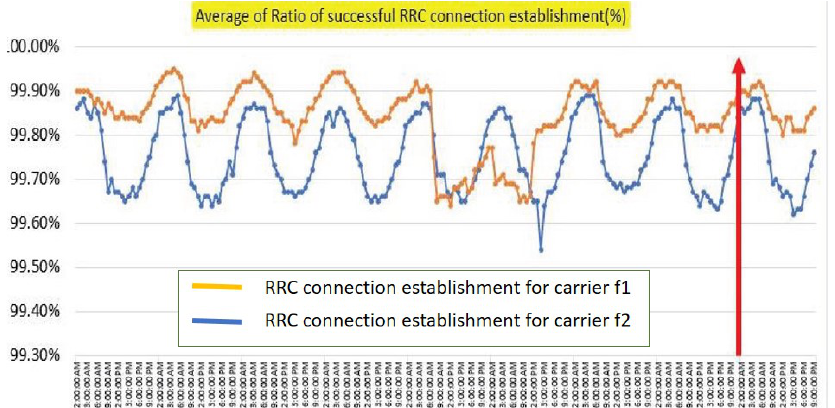
Figure 7. Radio resource connection (RRC) establishment percentage with the user equipment’s nodes efficiency of the tested architecture with various intervals connectivity